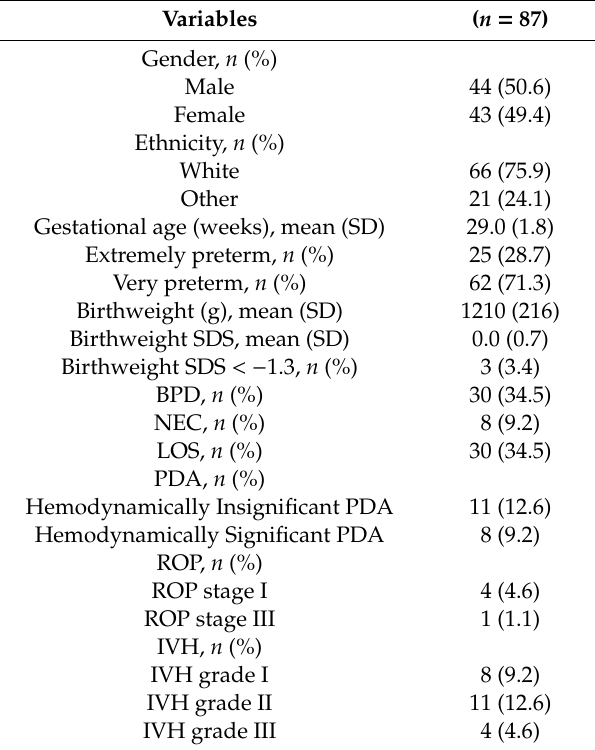
Table 3. Characteristics of the study